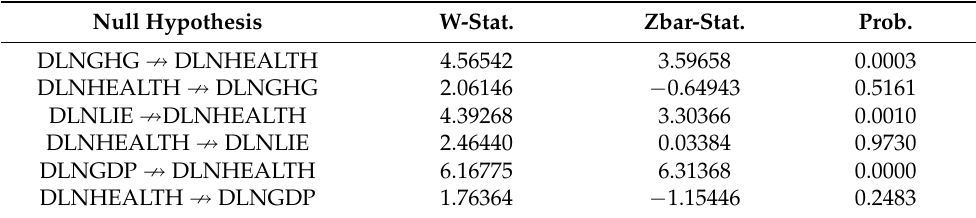
Table 7. Results of causality